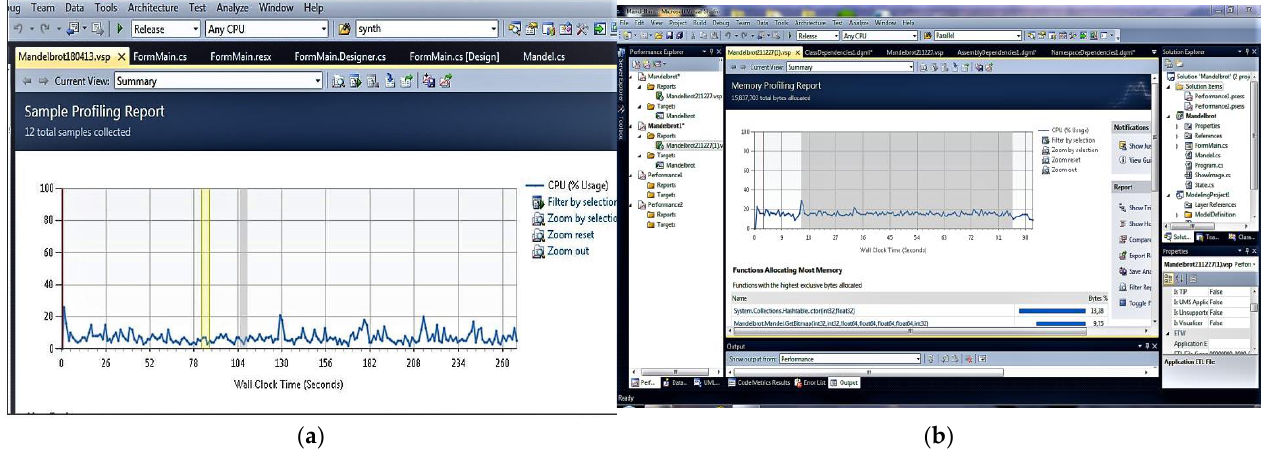
Figure 6. Evolution of CPU usage percentage over time. ( a ) During the running of a generation scenario, to support the interface, CPU resources are used at a rate of 20% over 260 s of test time. ( b ) Example of normal testing for a 90-s pattern. It is observed that the maximum level of use of the processor does not exceed 30% of the resources and that the average is approximately 20% in the random sequential generation test.